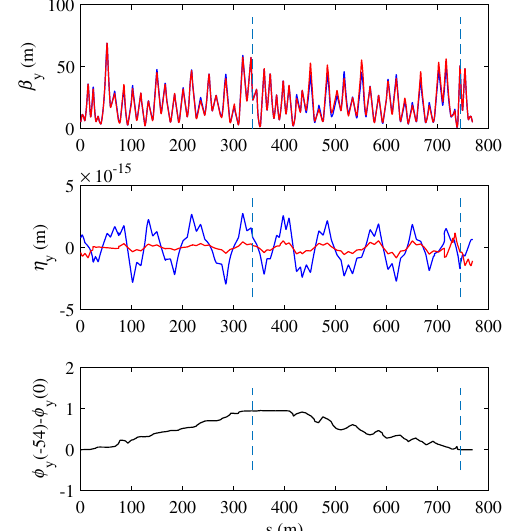
FIG. 2. The vertical Twiss parameter β y and the dispersion η y of two lattices: lat þ ð 0 Þ (blue line) and lat þ ð − 54 Þ (red line). The bottom plot shows the vertical betatron phase difference in units of radians between lat þ ð − 54 Þ and lat þ ð 0 Þ . Two dashed lines indicate the locations of the scraper ( s ¼ 336 . 5 m) and the e þ xBSM ( s ¼ 774 . 9 m).